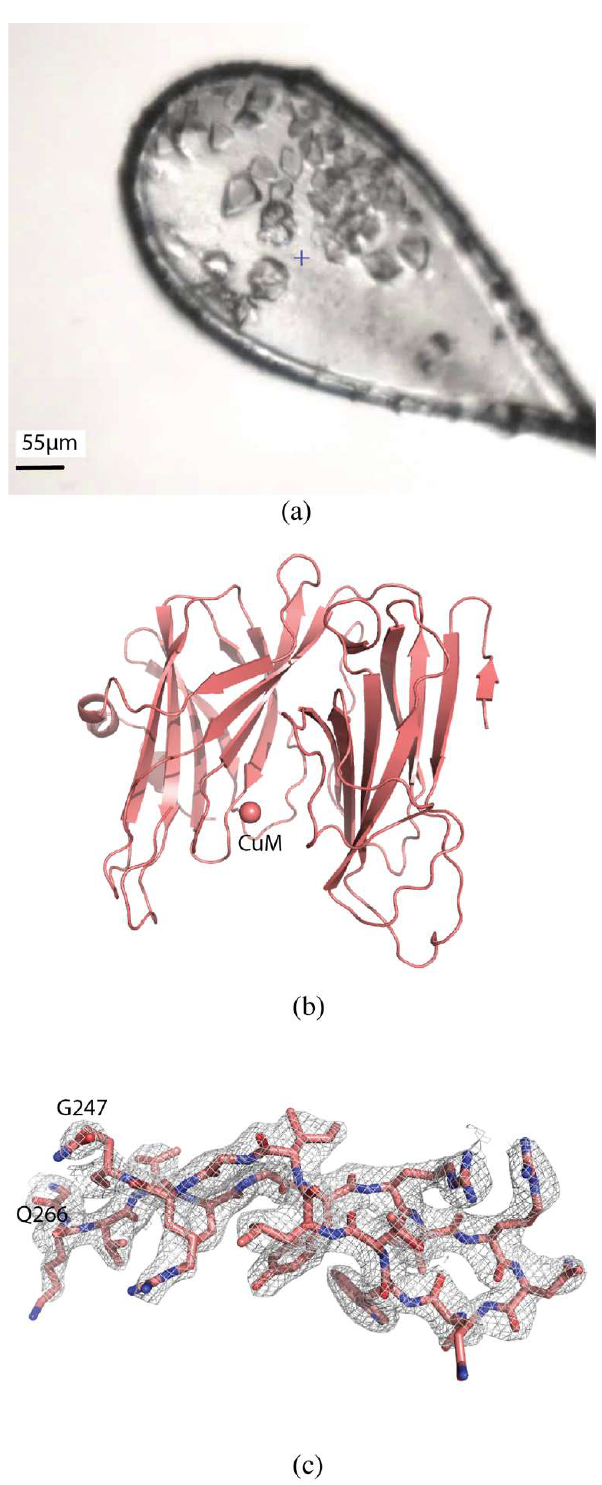
Figure 4. Serial data collection of H108A-PHM. ( a ) H108A-PHM crystals in loop. ( b ) Overall structure of H108A-PHM (PDB ID 6NCK). The single copper atom is shown as a sphere at the Cu M binding site. ( c ) 2mFo-DFc map contoured at 1.0 σ of a section of the protein.